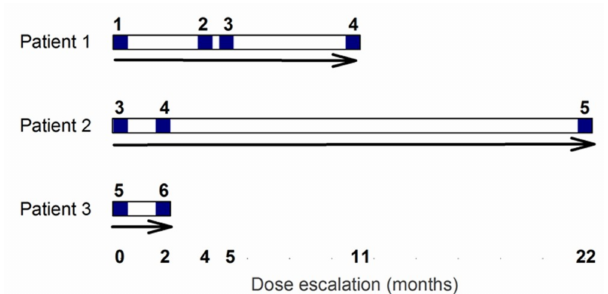
Figure 1. Dose escalation scheme for Patients 1, 2, and 3. Following a screening period of 28 days an intravenous dose of EE-TP was administered on day 0. Patients were escalated to the next dose following a safety review. Blue numbers refer to dose levels, where level 1 = 4 U/kg, level 2 = 9 U/kg, level 3 = 18 U/kg, level 4 = 29 U/kg, level 5 = 47 U/kg, and level 6 = 108 U/kg. Note that data pertaining to dose level 5 for Patient 2 is only covered in this